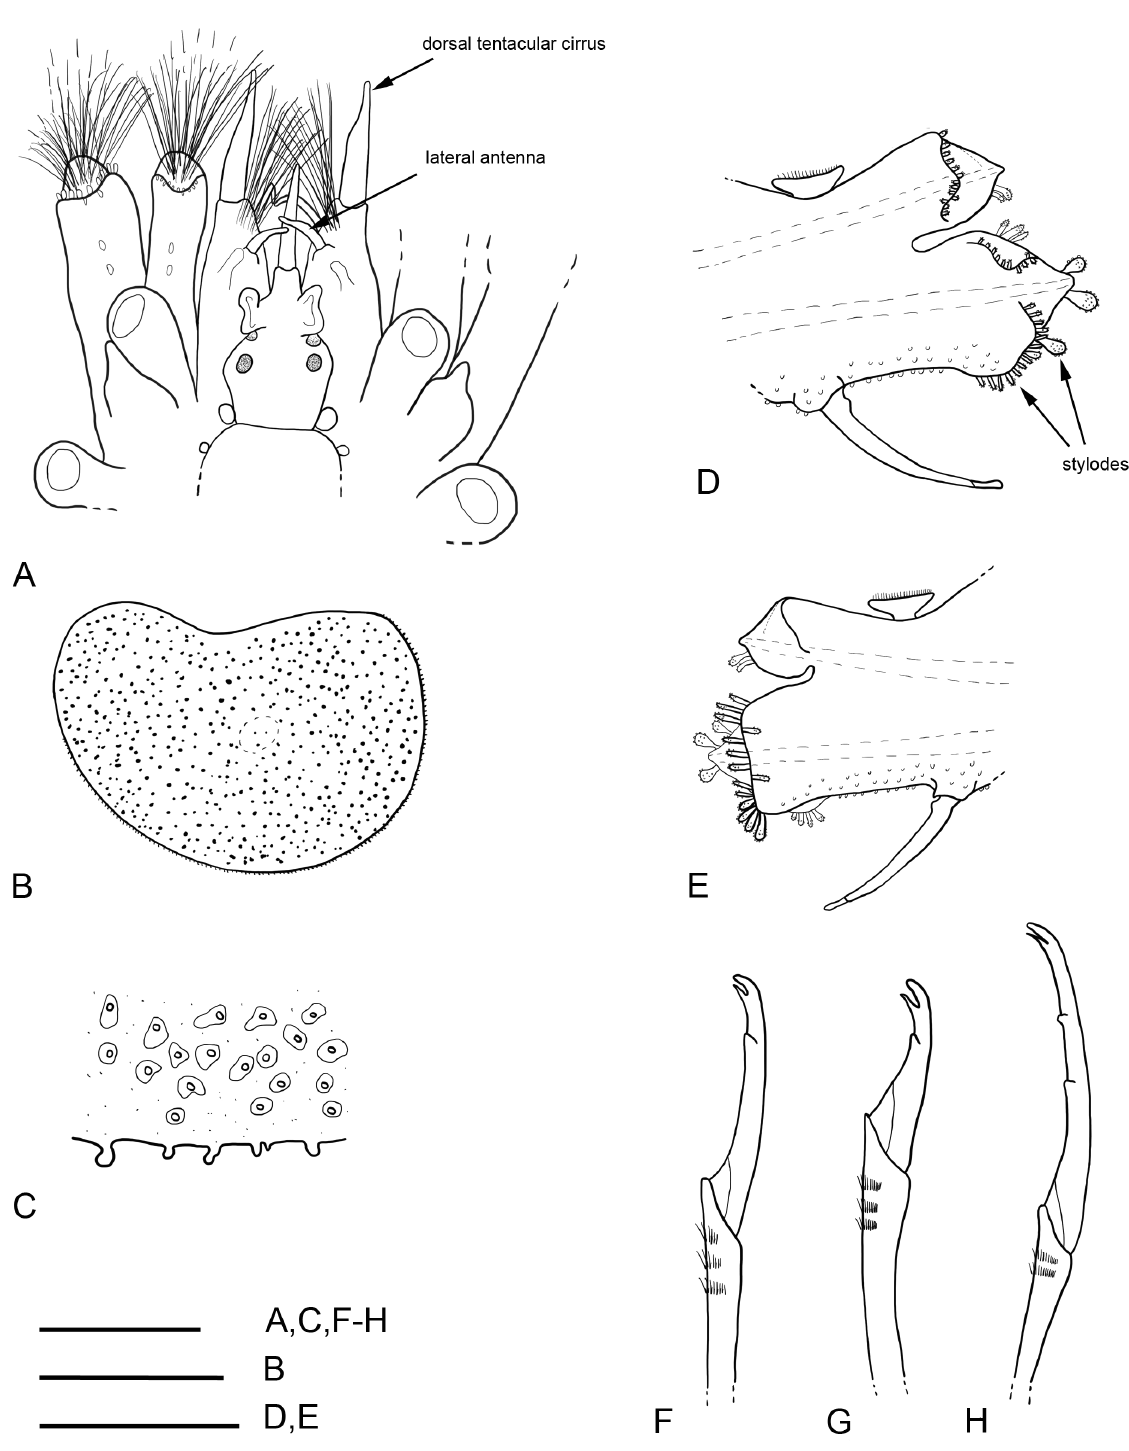
Fig. 6. Fimbriosthenelais zetlandica (McIntosh, 1876). TUM 39480 (A–B, D–E) and SMF 12682 (C, F–H). A . Anterior end, palps not figured, bent downwards. B . Right elytron of segment 5. C . Detail of posterior elytral margin. D . Left parapodium of segment 13, anterior view. E . Same, posterior view. F–H . Neurochaetae of segment 11, all distal part. F . Upper compound falciger. G . Middle compound falciger. H . Lower compound falciger. Scale bars: A, D–E = 500 µm; B = 1 mm; C, F–H =